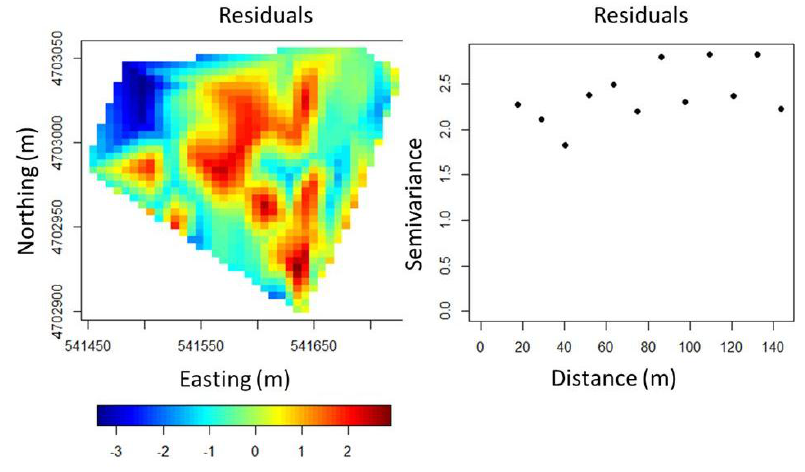
Figure 7. Map of residuals ( left ) and empirical semivariogram of residuals ( right ) of the linear multiple regression model for trunk